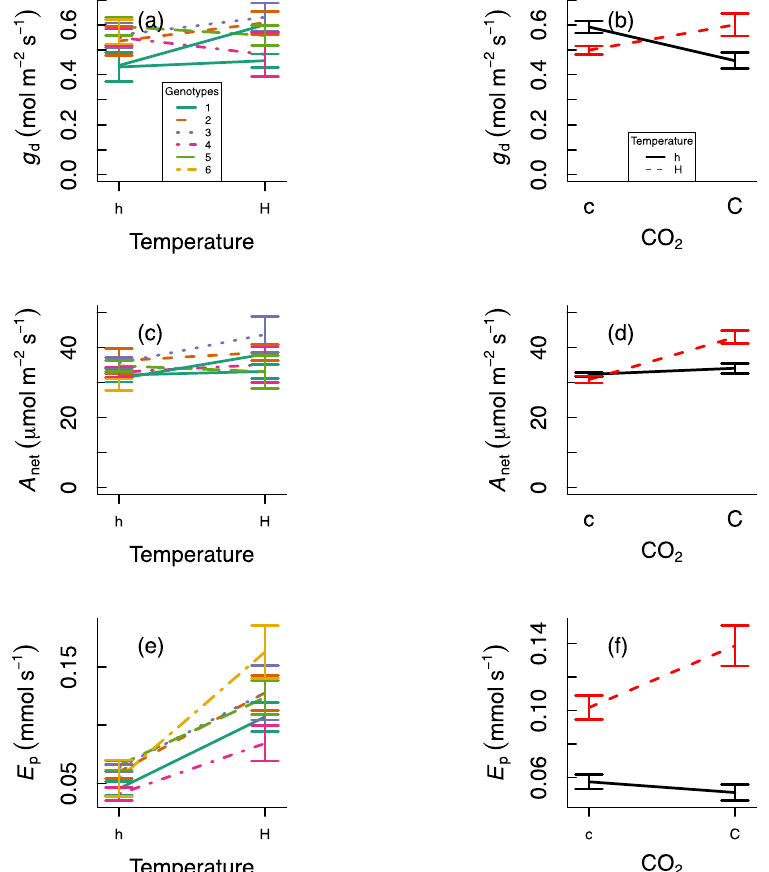
Figure 2. Experimental responses of daytime stomatal conductance ( g d ; a , b ), net photosynthesis ( A net ; c , d ), and whole plant transpiration ( E p ; e , f ) in response to no heat-wave exposure (h), heat-wave exposure (H), ambient CO 2 (c), and elevated CO 2 (C). Data are presented as reaction norms for six genotypes as a function of temperature (figures a , c , e ) and as reaction norms for temperature as a function of CO 2 treatment (figures b , d , f ). Error bars indicate standard errors.